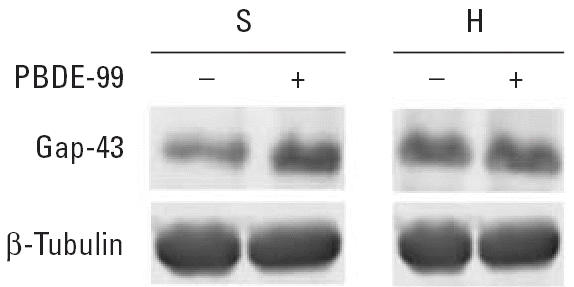
Western blot validation of Gap-43 expression. Gap-43 and the endogenous reference protein β-tublin were simultaneously detected in control (−) and PBDE-99–exposed (+) striatum (S) and hippocampus (H) samples after SDS–PAGE and electroblotting to nitrocellulose.